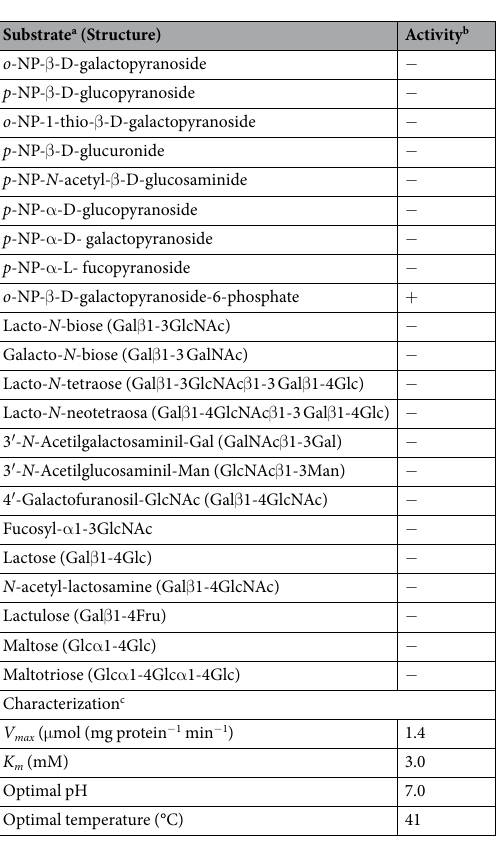
Table 1. Activity and characterization of the phospho- β -galactosidase LacG. a Carbohydrates used as substrates. NP, nitrophenyl; Glc, glucose; Gal, Galactose; GlcNAc, N -acetylglucosamine; GalNAc, N -acetylgalactosamine; Man, mannose; Fru, fructose. b + , substrate is totally hydrolyzed after 16 h reaction in the conditions described in the “Materials and methods” section; − , no activity detected. c The enzyme activity was determined with o - nitrophenyl- β -D-galactopyranoside-6-P as the substrate.